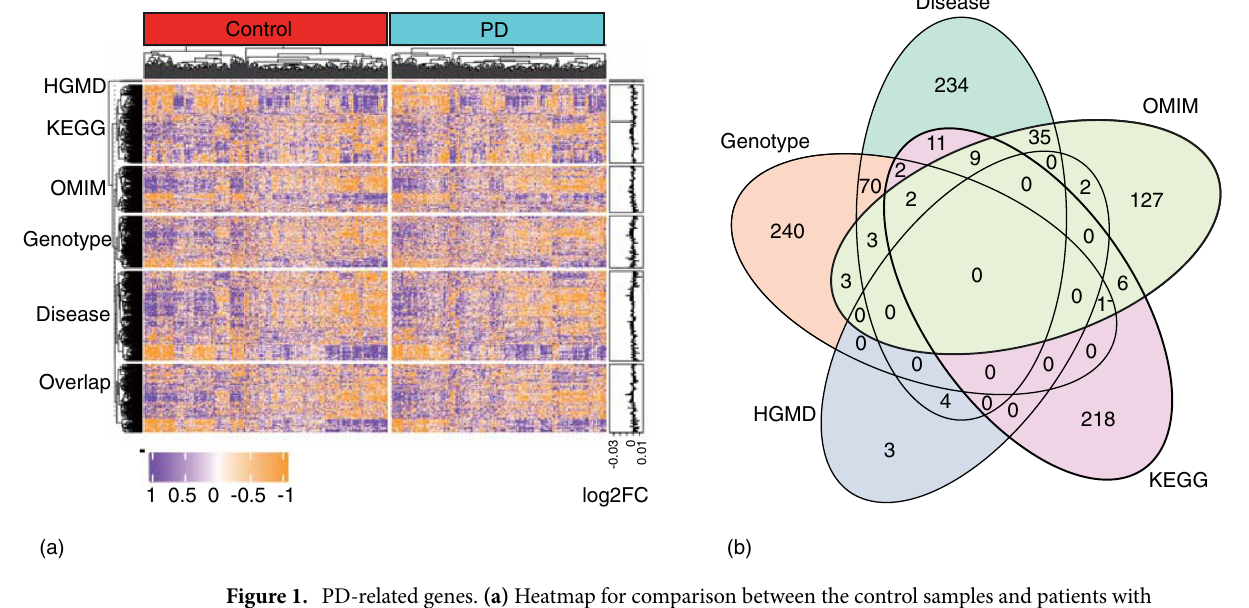
Figure 1. PD-related genes. (a) Heatmap for comparison between the control samples and patients with PD. Colors correspond to standardized log2-transformed expression values. Heatmap created using R and “pheatmap” package 48 . (b) Veen diagram show the number of PD-related genes collected from five databases. PD, parkinson’s disease. Veen diagram created using R and “ggVennDiagram” package 49